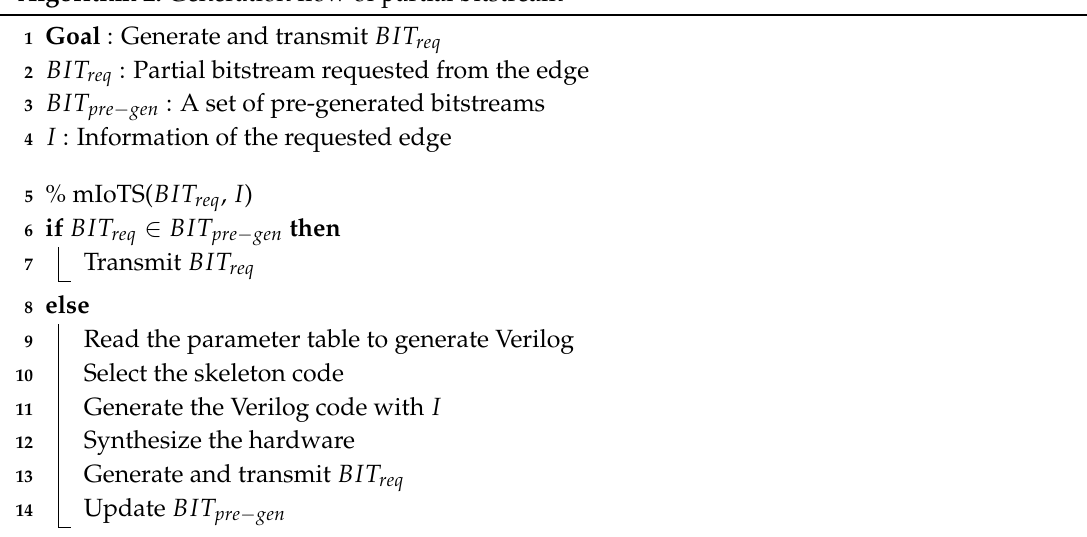
Algorithm 2: Generation flow of partial